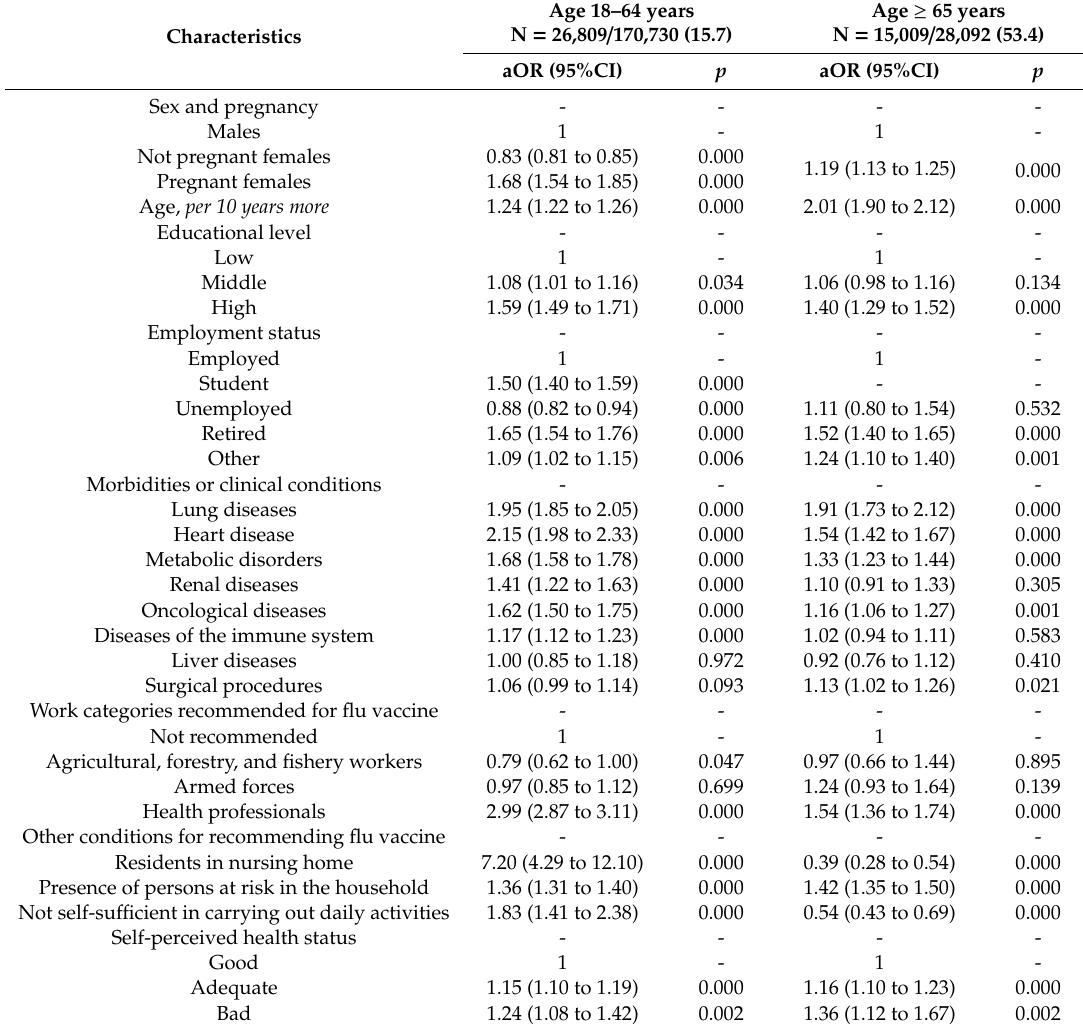
Table 2. Multivariable binary logistic regression analysis on the probability of being vaccinated during the 2019 / 2020 flu season or not according to being 18–64 years old or ≥ 65 years